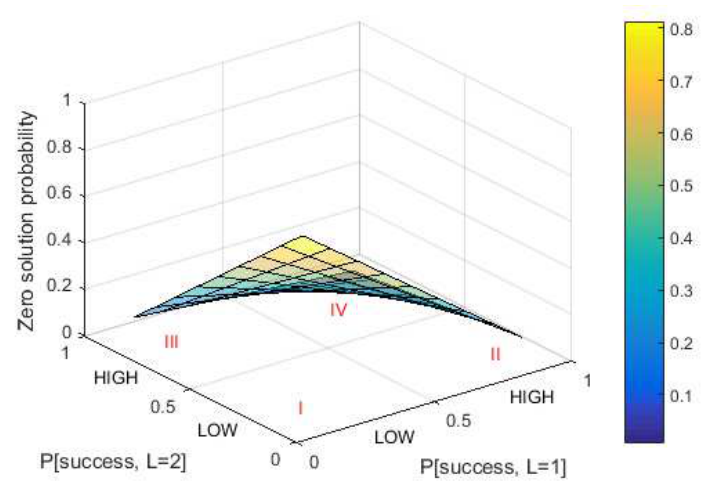
Figure 5. Zero solution probability in DCP for L max = 2.